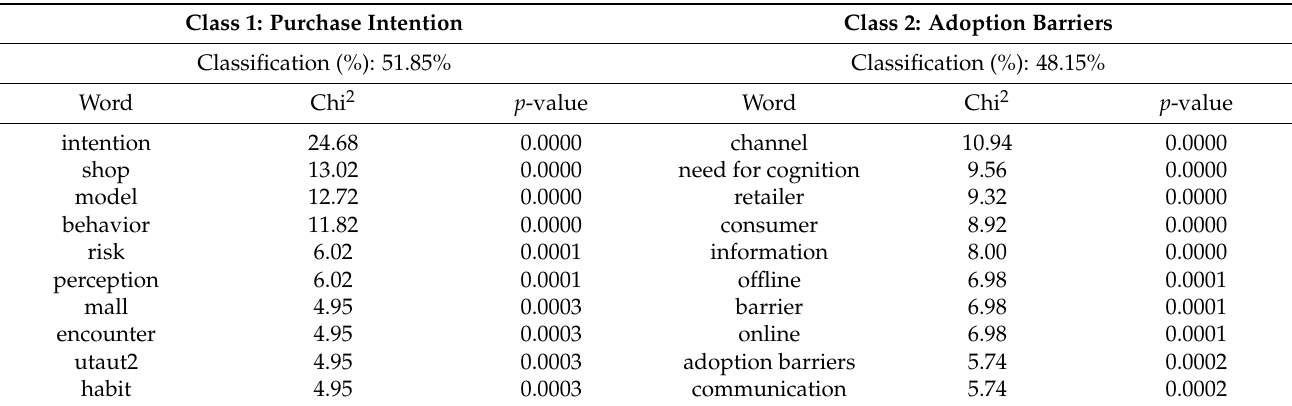
Table 3. Typology analysis: pre-purchase